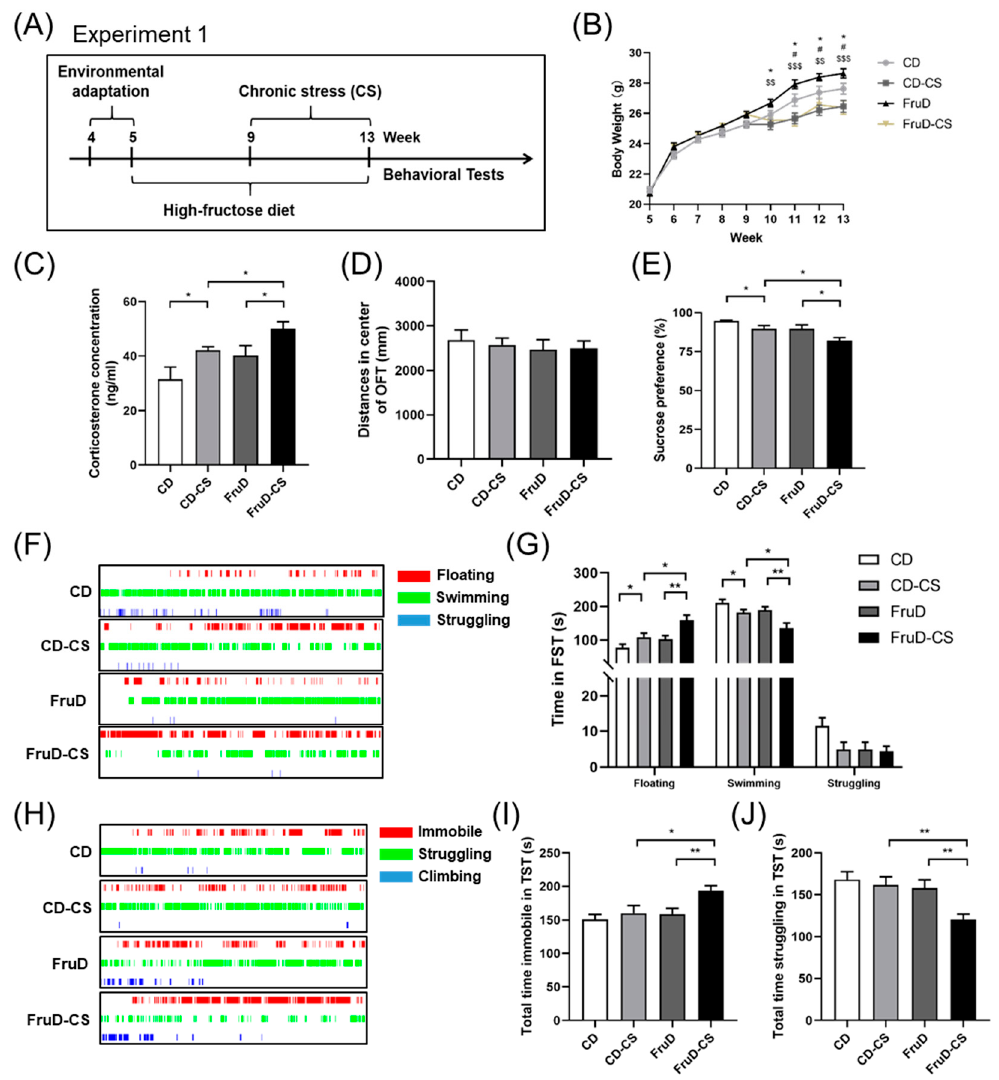
Figure 1. Chronic stress-induced depressive-like behaviors are aggravated in FruD mice. ( A ) Schematic diagram of mice dealing with high fructose diet and chronic stress. ( B ) Body weight of mice (* CD versus FruD group; # CD vs. CD-CS group; $ FruD vs. FruD-CS group). ( C ) Corticosterone level in serum of mice. ( D – J ) Behavioral test and representative state images of mice in OFT ( D ), SPT ( E ), FST ( F , G ) and TST ( H – J ). Data are expressed as mean ± SEM, * p < 0.05, ** p < 0.01; # p < 0.05; $$ p < 0.01, $$$ p < 0.001.